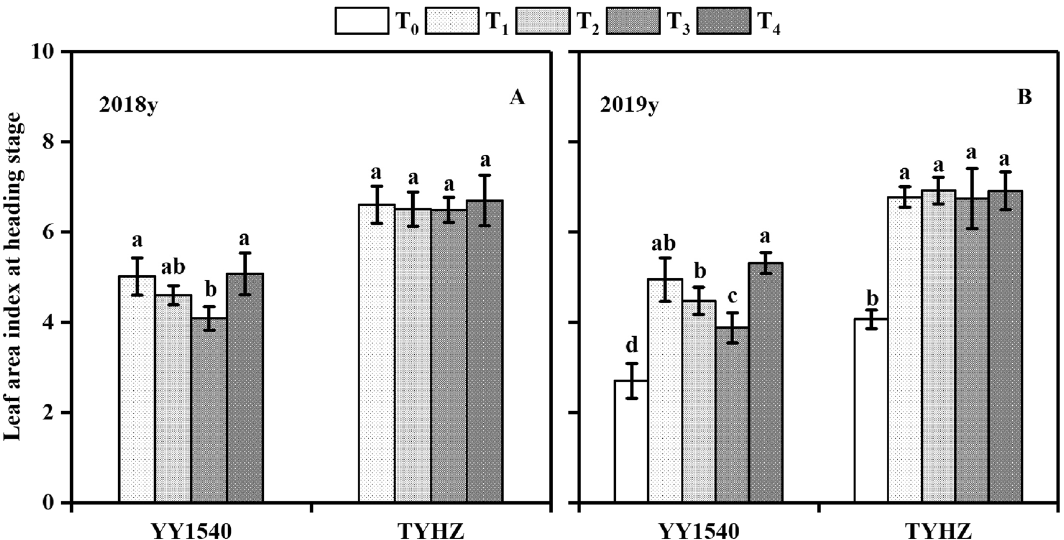
Figure 3. Leaf area index at the heading stage under different treatments. ( A ) 2018; ( B ) 2019. Bars superscripted by different lower-case are significantly different among treatments. T 0 no-nitrogen application control, T 1 traditional nitrogen application, T 2 single-dose controlled-release nitrogen application, T 3 70% controlled-release nitrogen as side-deep fertilization with machine transplanting and 30% as topdressing applied at the tillering stage, T 4 70% controlled-release nitrogen as side-deep fertilization with machine transplanting and 30% as topdressing applied at the panicle initiation